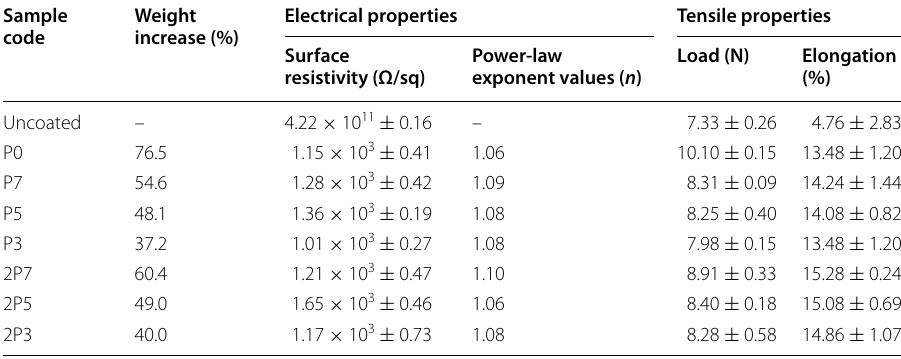
Table 1 Characteristics of CNF/PVDF-HFP composite coated on cotton fabrics of various circuit